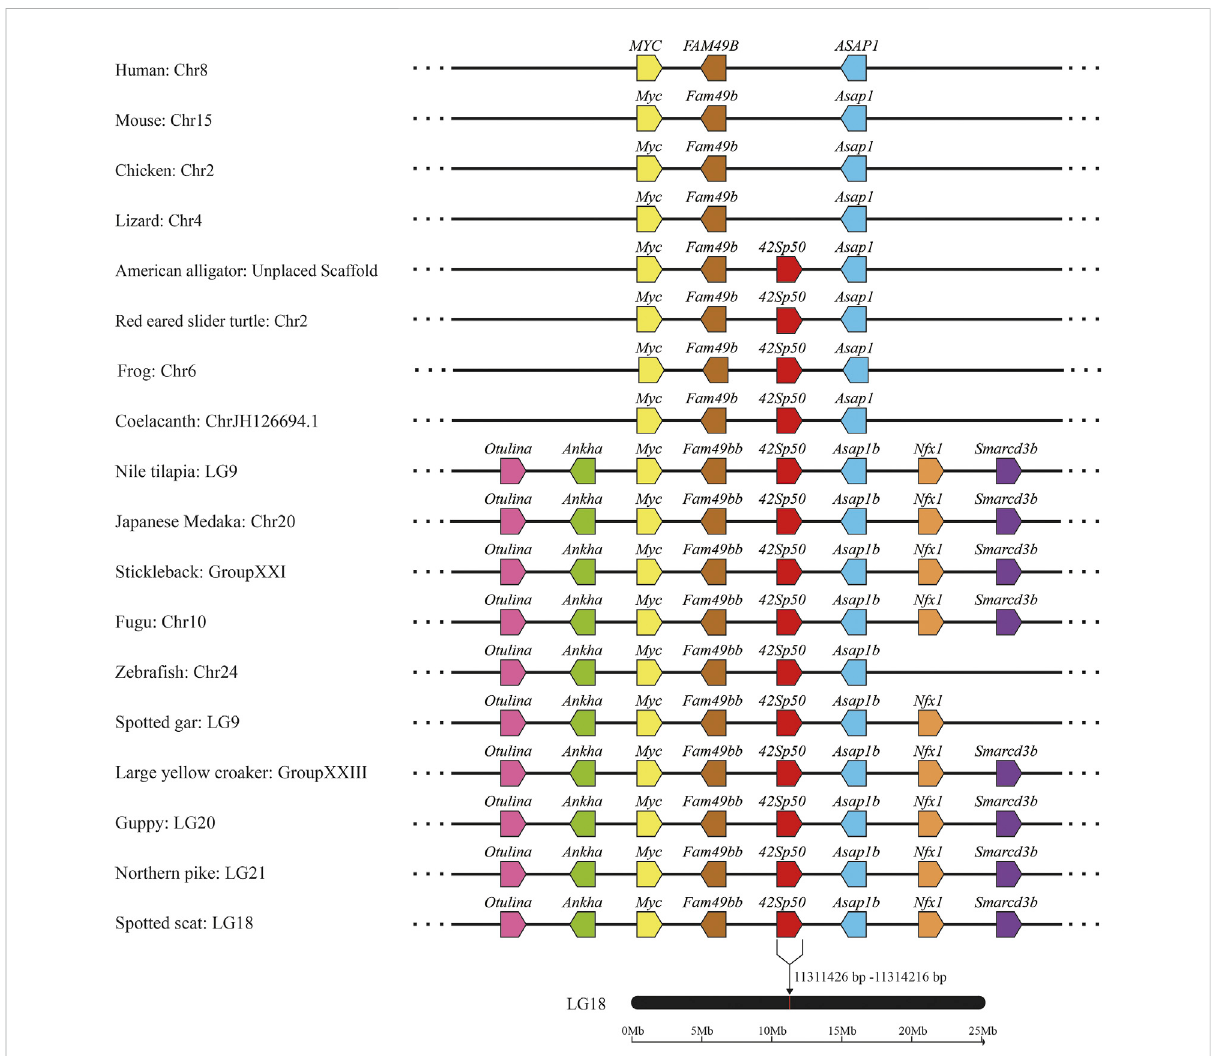
Syntenic analysis of 42Sp5 0 genes from spotted scat using the genomes of 18 selected vertebrate species (human, mouse, chicken, lizard, American alligator, red eared slider turtle, frog, coelacanth, Nile tilapia, Japanese medaka, stickleback, Fugu, zebra fi sh, spotted gar, large yellow croaker, guppy and northem pike). Genes are represented by pentagons, and the directions of the reading frames are represented by the direction that the pentagon is pointing. Genbank accession numbers of these gene are provided in Supplementary Table